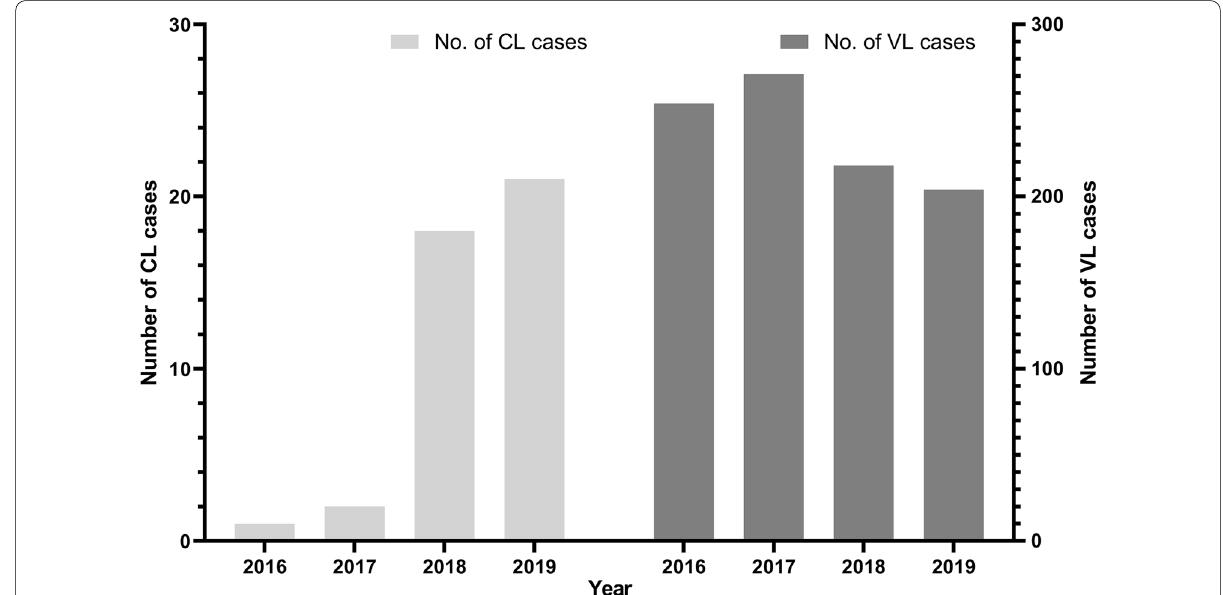
Fig. 2 Year wise number of cutaneous leishmaniasis (CL) and visceral leishmaniasis (VL) cases in Nepal,